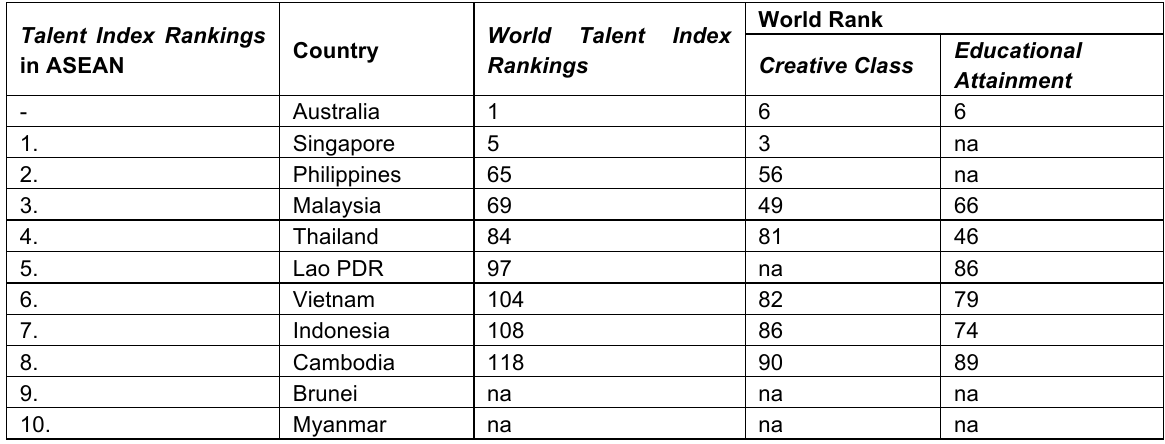
Table 6: Global Talent Index Rankings